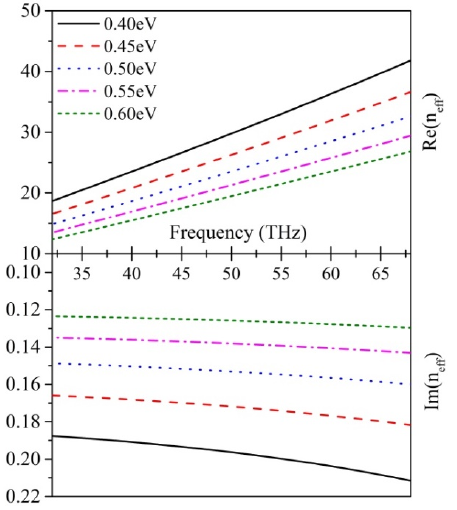
Figure 5. Variation of the graphene effective refractive index in relation to the frequency at various chemical potentials. The top part is the real part of effective index and the bottom part is the imaginary part of effective refractive index.